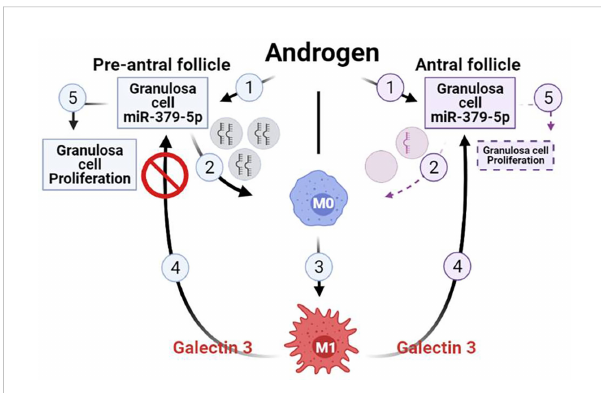
FIGURE 4 Hypothetical model illustrating that uptake of GC-derived exosomal miR-379-5p by macrophages increases M1 and macrophage release of galectin-3, a response which inhibits GC proliferation in antral but not preantral follicles. Androgen induces GC exosomal miR379 release from preantral but not antral follicles. The uptake of GC- derived exosomal miR379 suppresses PDK1 in macrophages, a cellular mechanism shifting macrophage polarization towards M1. M1 macrophage secretes higher level of galectin-3 in FF, a in fl ammatory cytokine that speci fi cally suppressed GC proliferation in antral but not preantral follicles. (Created in